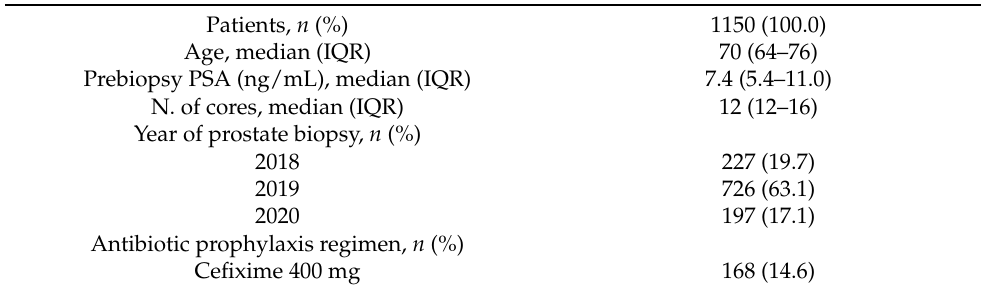
Table 1. Descriptive baseline characteristics and clinicopathological features for the cohort of 1150 pa- tients who underwent transrectal ultrasound prostate